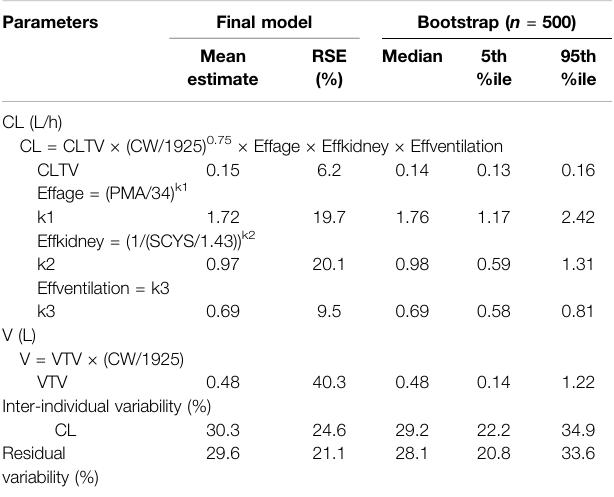
TABLE 4 | Final estimates of population pharmacokinetic parameters of vancomycin and bootstrap results — from the alternative model based on Serum Cystatin C (CYS model).